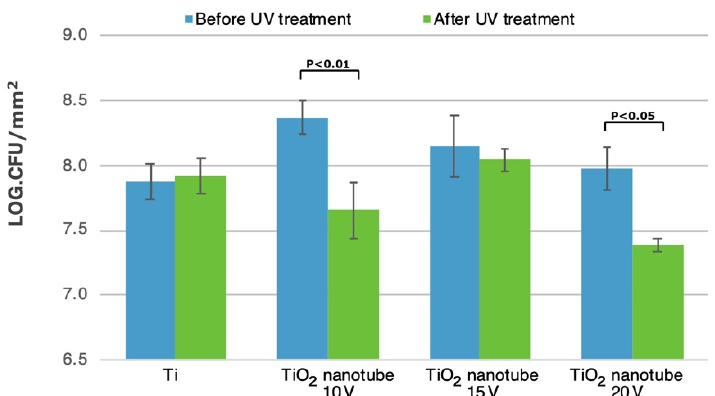
Figure 3. The amount of S. mutans biofilm formation on the experimental specimens before and after UV treatment. Data are presented as mean ± standard deviation ( n = 4). UV treatment caused statis ‐ tically significant decreases in biofilm formation only for 10 V and 20 V TiO 2 nanotubes.